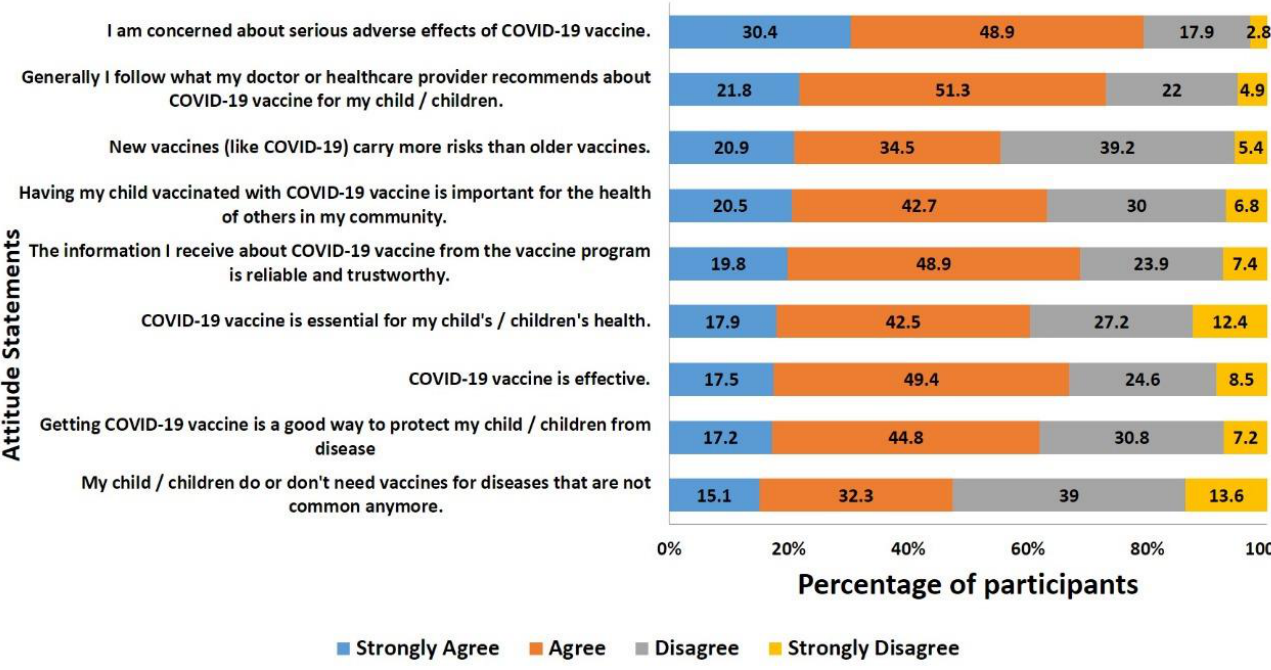
Figure 1. Parental attitude regarding the importance of vaccinating their children against the COVID-19.